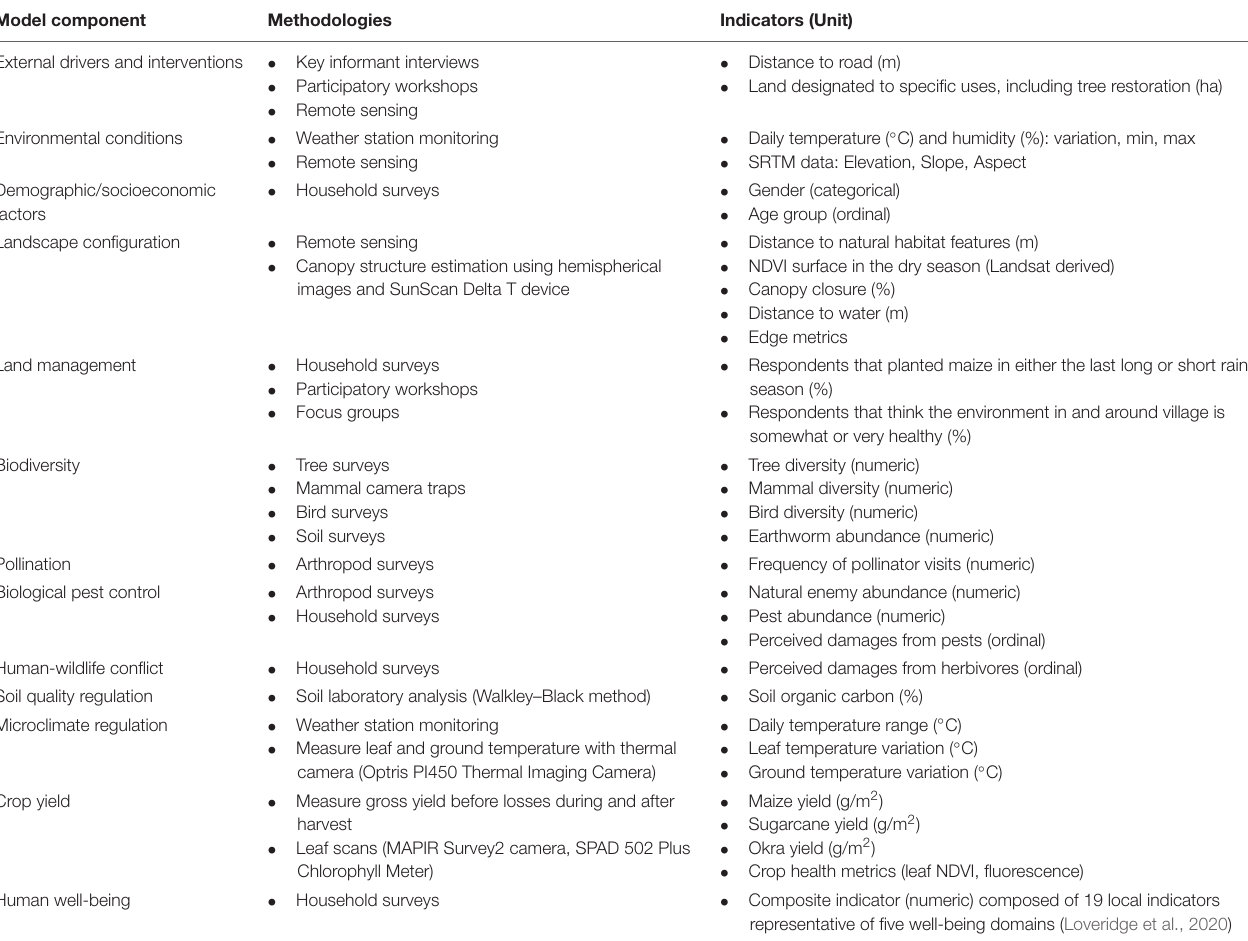
TABLE 2 | List of locally adjusted methodologies and indicators that are being used to generate data for the system model that will analyse biodiversity, well-being, and crop yield outcomes resulting from interventions and practices implemented in the Kilombero landscape. Model